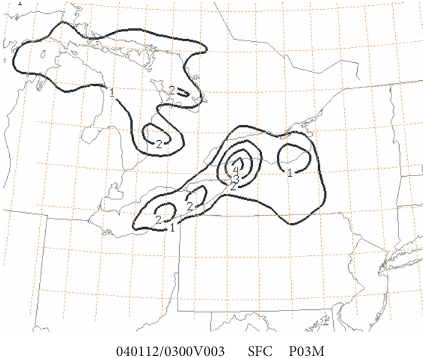
Figure 10: 3-hour accumulated liquid precipitation (solid, mm) in the NARR for the period ending at 0300 UTC 12 January